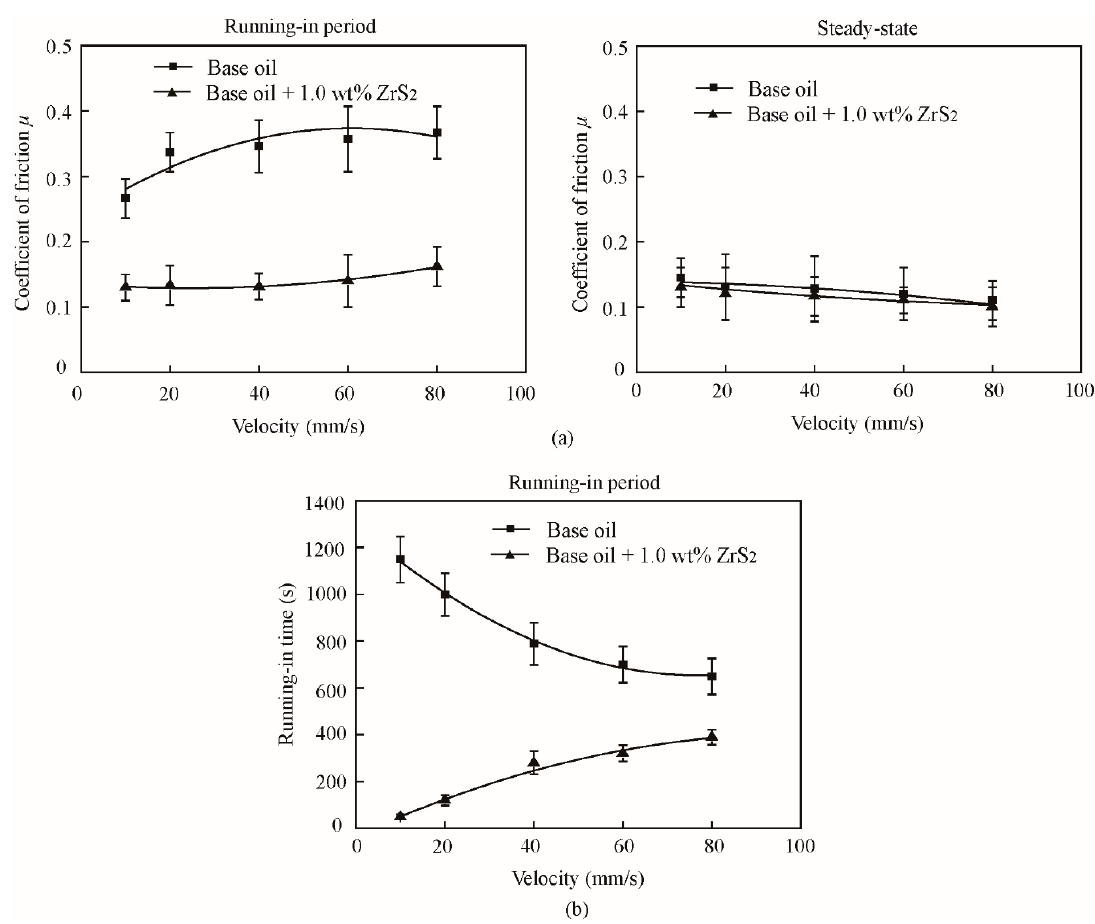
Figure 17. ( a ) Average friction coefficient and ( b ) running ‐ in time of the base oil and that with 1.0 wt% ZrS 2 nanobelt additives under different velocities.